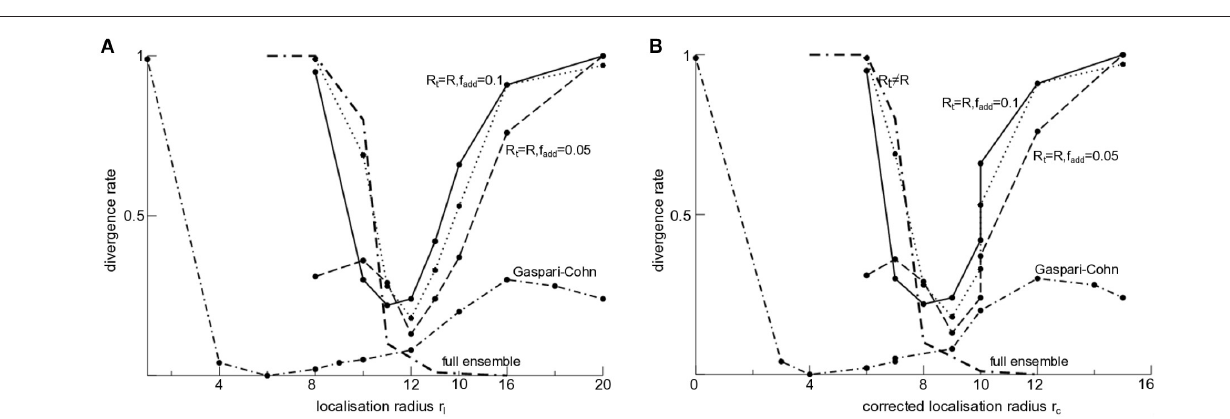
0.1 R t due to lack of knowledge of this true value. = 6=